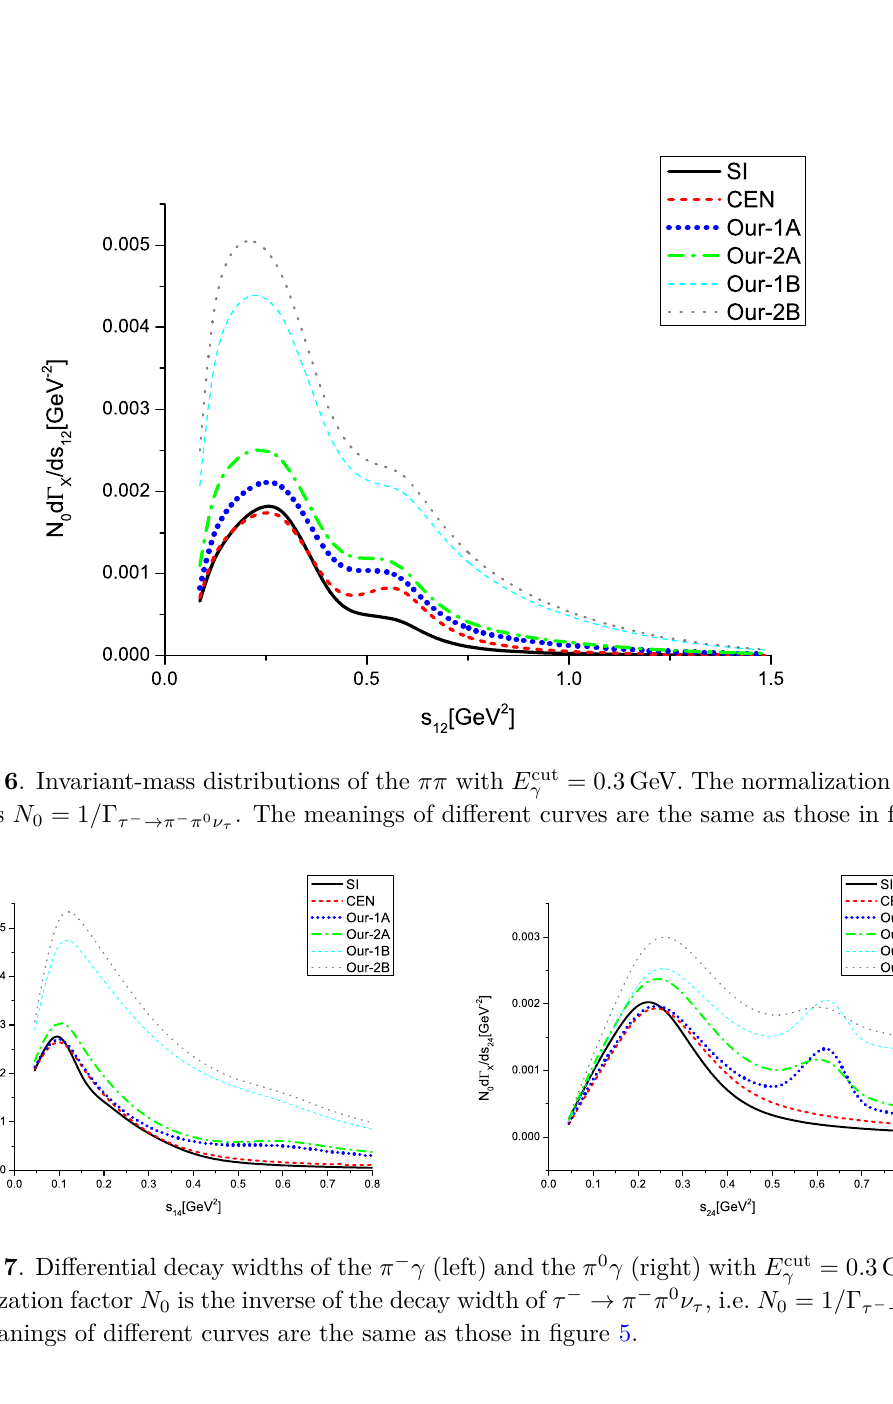
= 0 . 3 GeV. The γ . τ − → π − π 0 ν τ